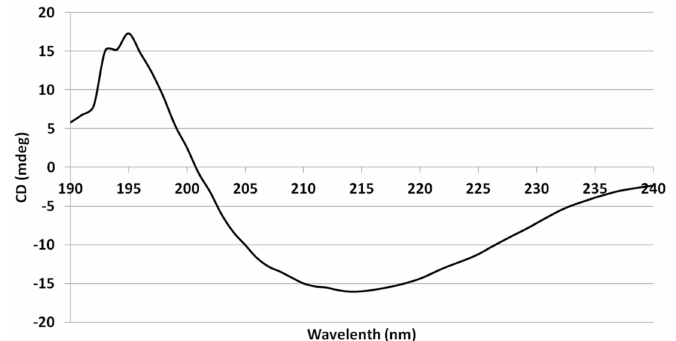
Figure 8. The CD spectra of leptucin. Analysis of the results showed that the peptide comprises alpha helices (20.4 %), beta sheets (43.1%), turn (11.6 %), and random coil (25%).